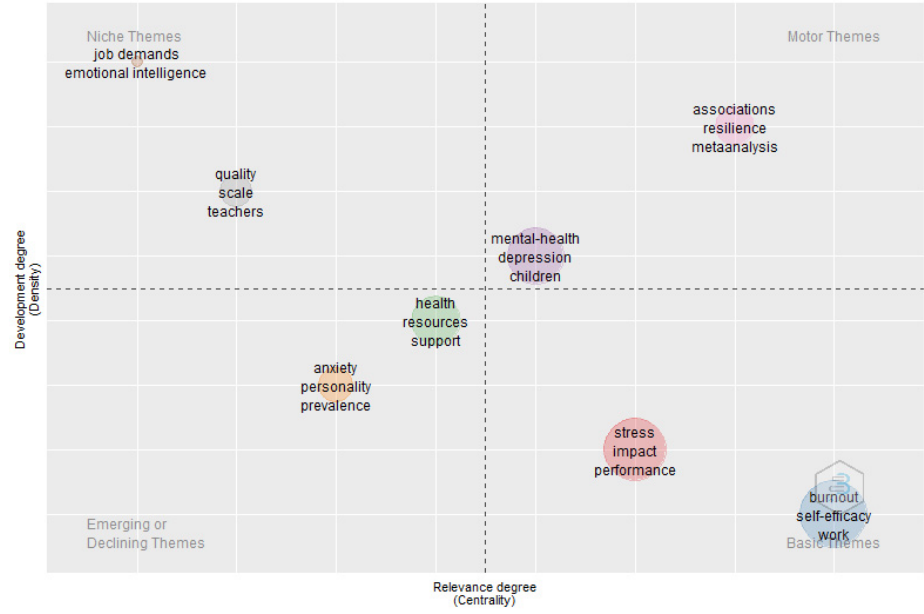
Figure 13. Strategic diagram of stress and burnout in teachers during the pandemic.